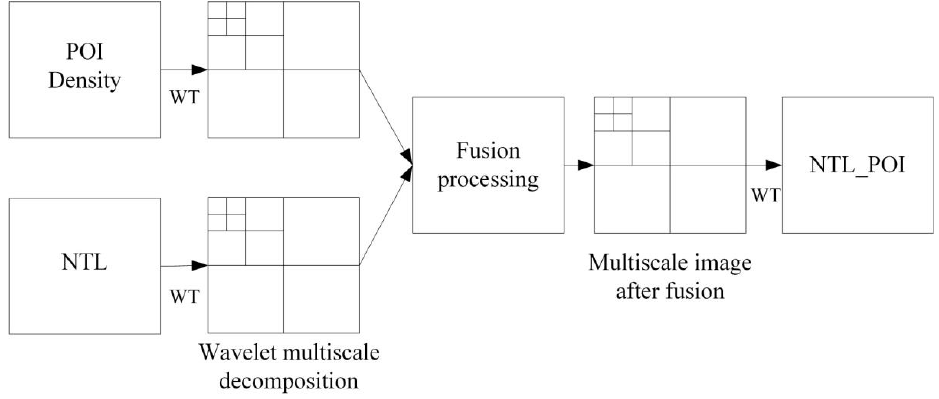
Figure 4. Principle of wavelet transform.